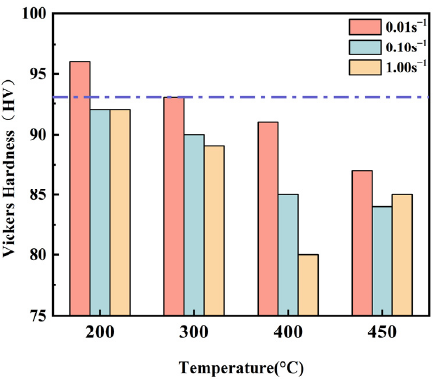
Figure 4. Vickers hardness at di ff erent temperatures and strain rates for the